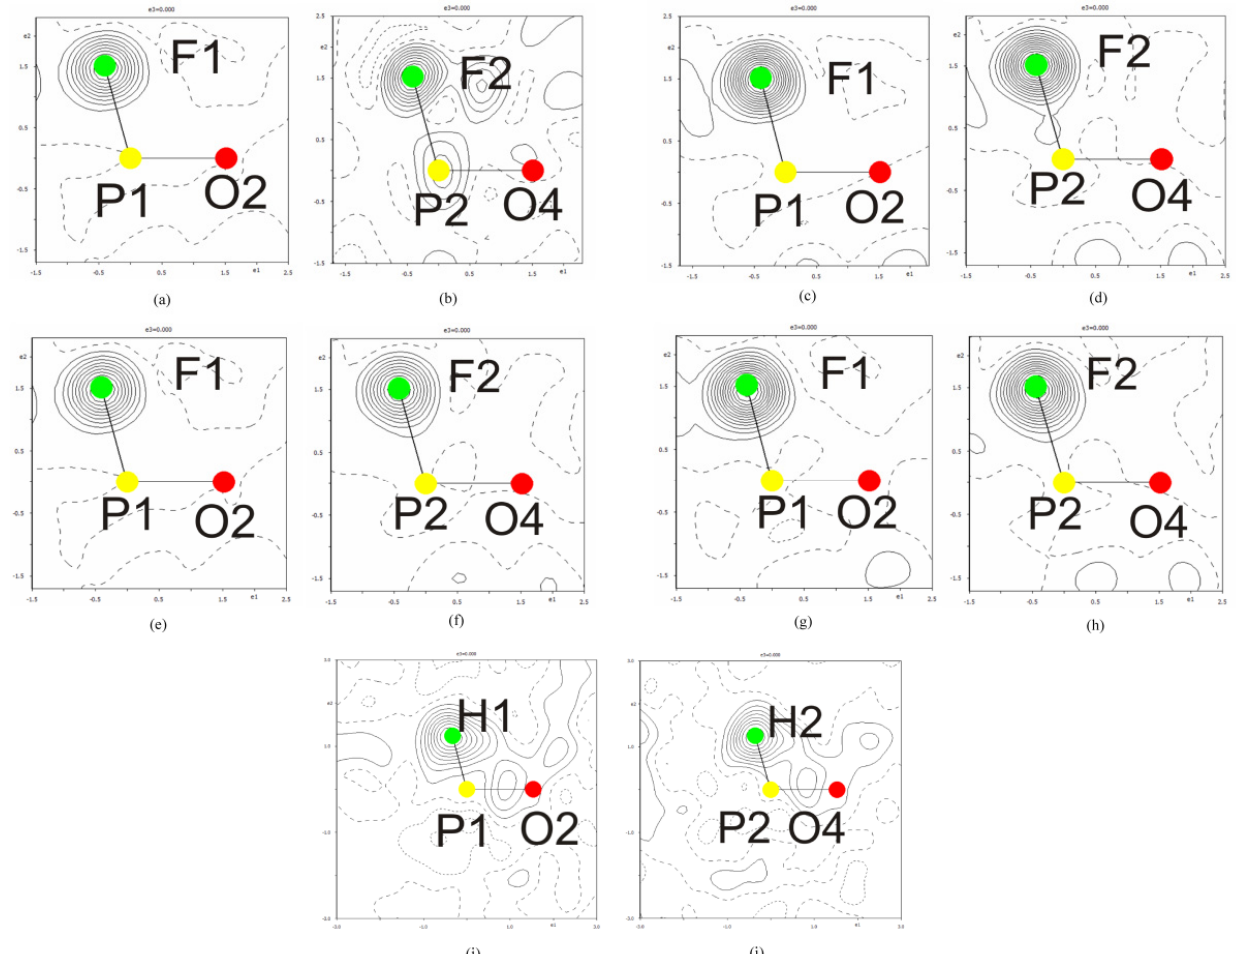
Figure 1. The difference electron density [eÅ − 3 ] before including the atoms F1/H1 and F2/H2 into the title crystals. ( a , b ) bis(guanidinium) trioxofluorophosphate—compound ( I ); ( c , d ) bis(guani- dinium) trioxofluorophosphate-phosphite (0.716/0.284)—compound ( II ); ( e , f ) bis(guanidinium) tri- oxofluorophosphate-phosphite (0.501/0.499)—compound ( III ); ( g , h ) bis(guanidinium) trioxofluor- ophosphate-phosphite (0.268/0.732)—compound ( IV ); ( i , j ) bis(guanidinium) phosphite compound ( V ). The increment of the contours is 0.5 eÅ − 3 . Positive, zero and negative electron density is depicted by the full, dotted and dashed lines, respectively. The Figure was prepared by [14].